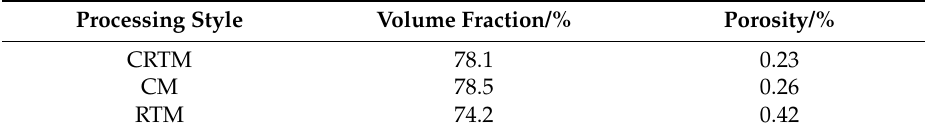
Table 7. Volume fraction and porosity of composite samples prepared by CRTM, RTM, and